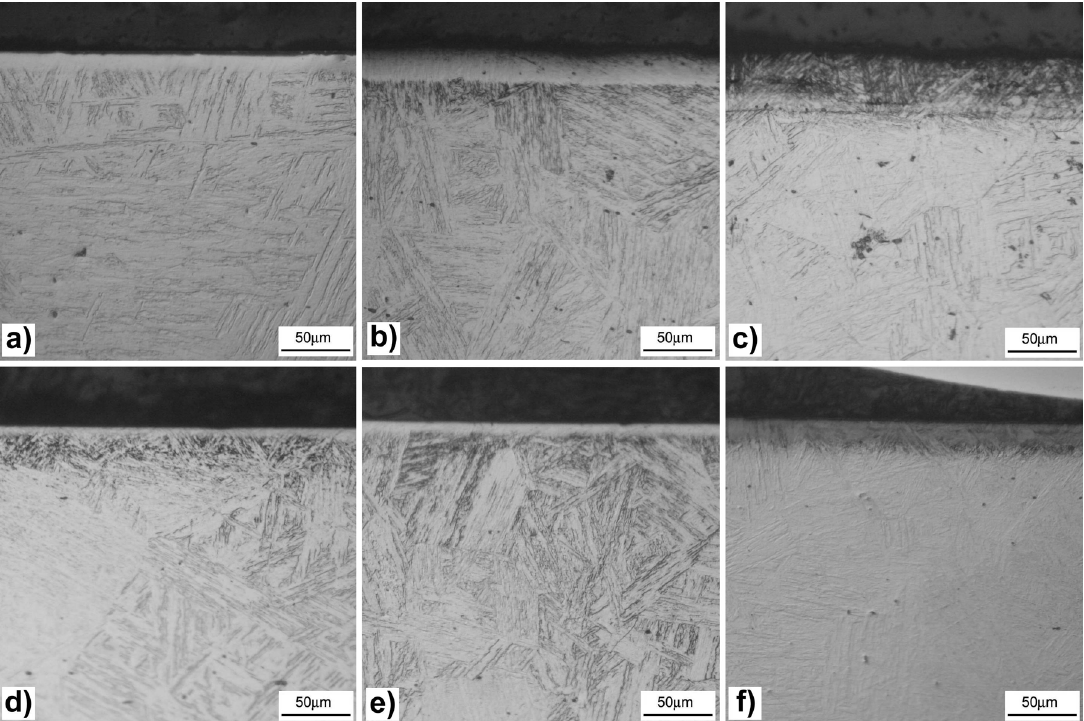
Figure 1. Light optical microscopy of plasma (a-c) nitrided and (d-f) nitrocarburized SMSS samples at (a, d) 400°C, (b, e) 450°C and (c, e) 500°C for 5h